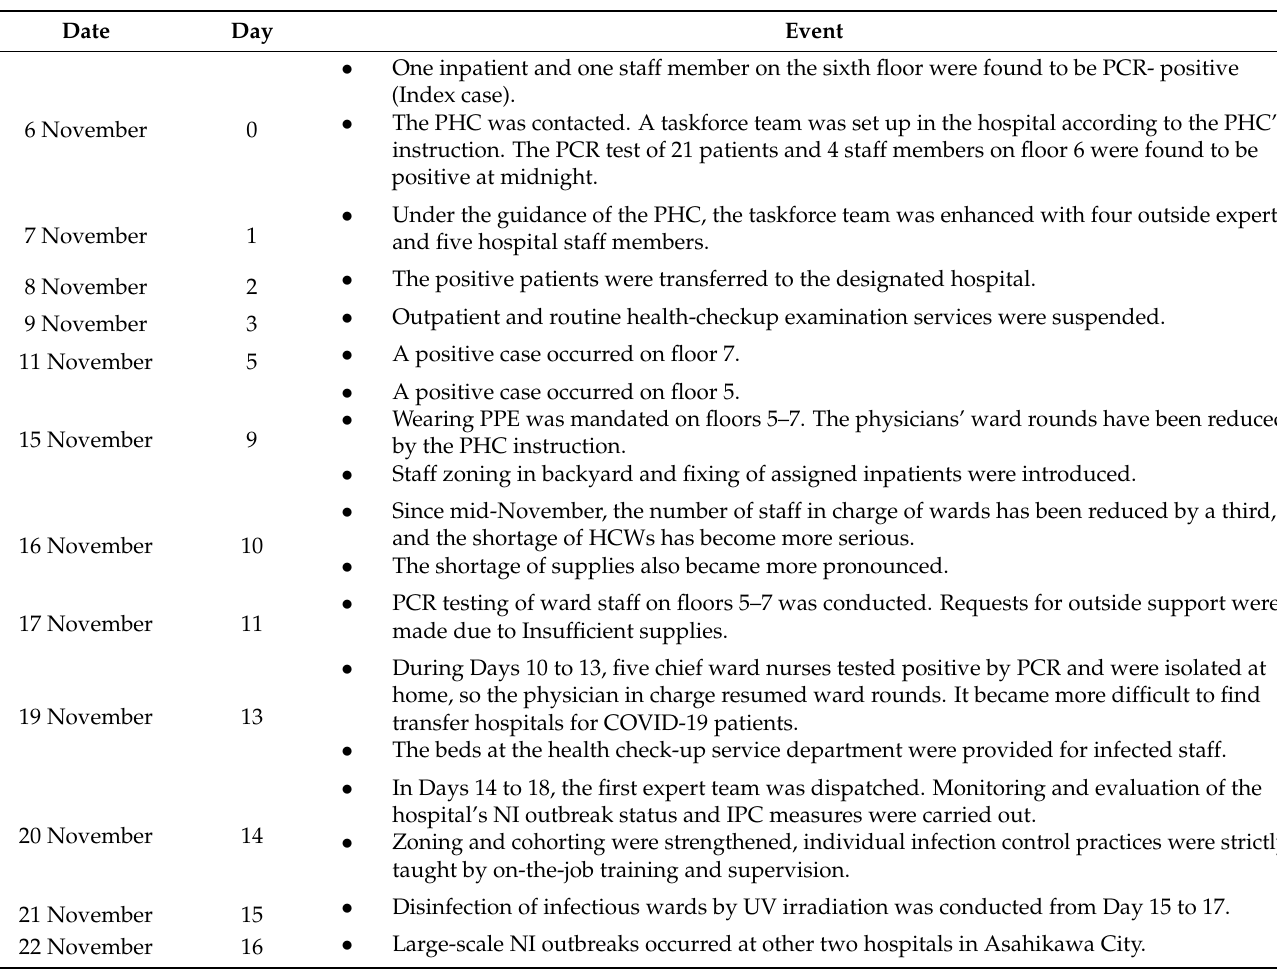
Table 4. Timeline of events at Hospital